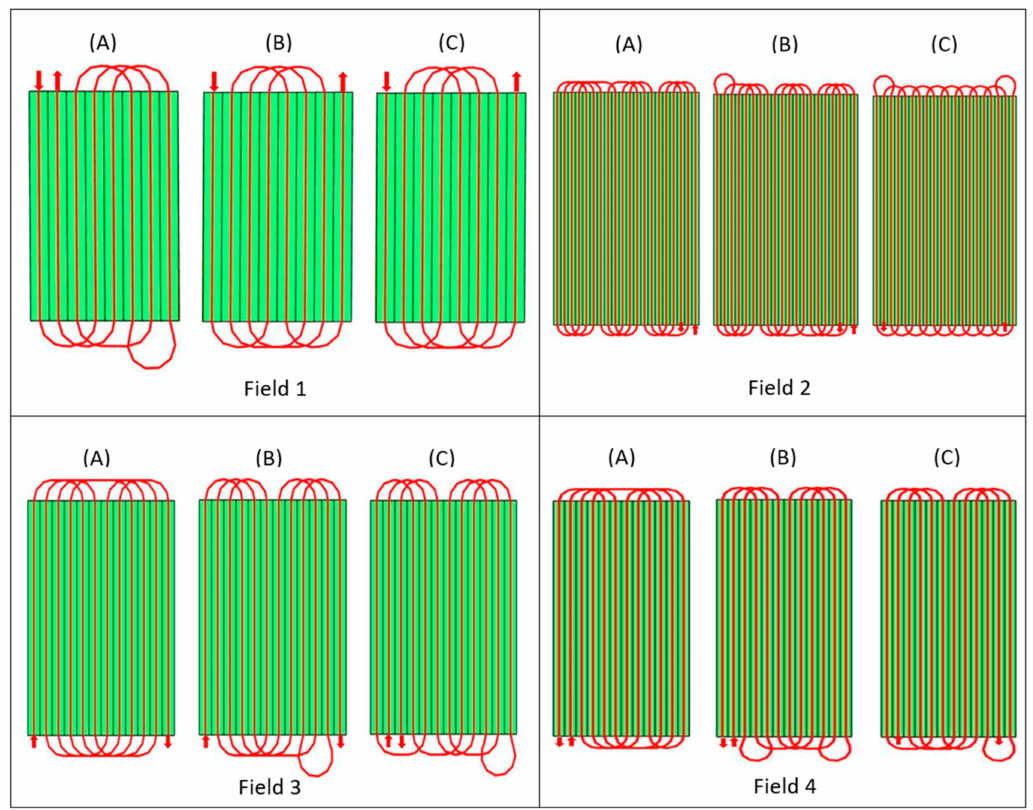
Figure 5. Comparison of the results obtained by applying di ff erent approaches: ( A ) method proposed in [11], ( B ) method proposed in [29], and ( C ) method proposed in this study. The track’s index starts from the left and moves to the right in each field.